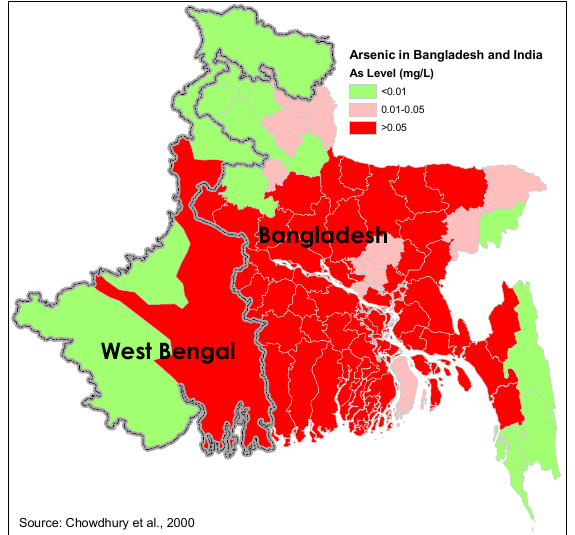
Figure 1: Arsenic concentrations in groundwater in Bangladesh and West Bengal, India [4].